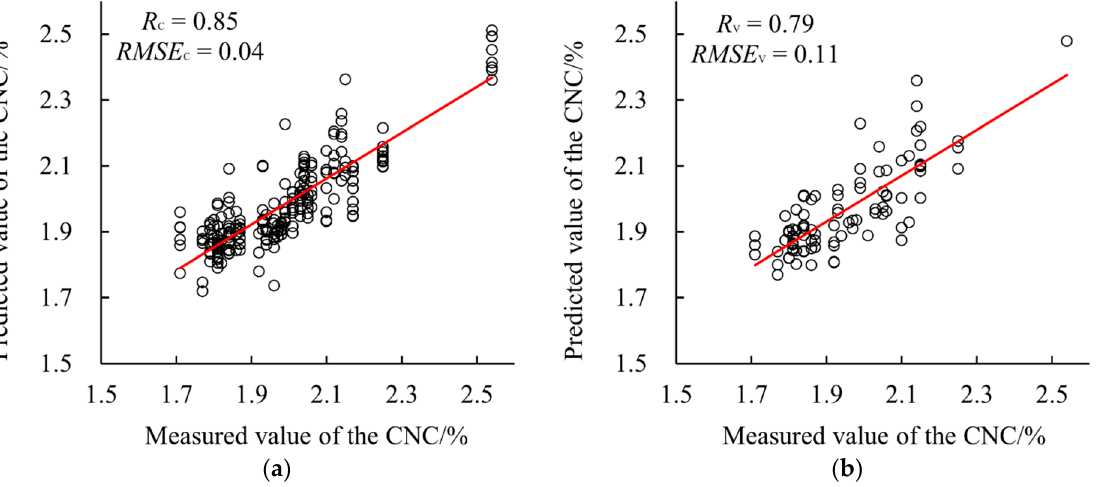
Figure 7. CNC prediction result of the PLS model based on the five-band reflectance combined with NGBDI, SRPI and NPCI. ( a ) The calibration result; ( b ) the validation result.